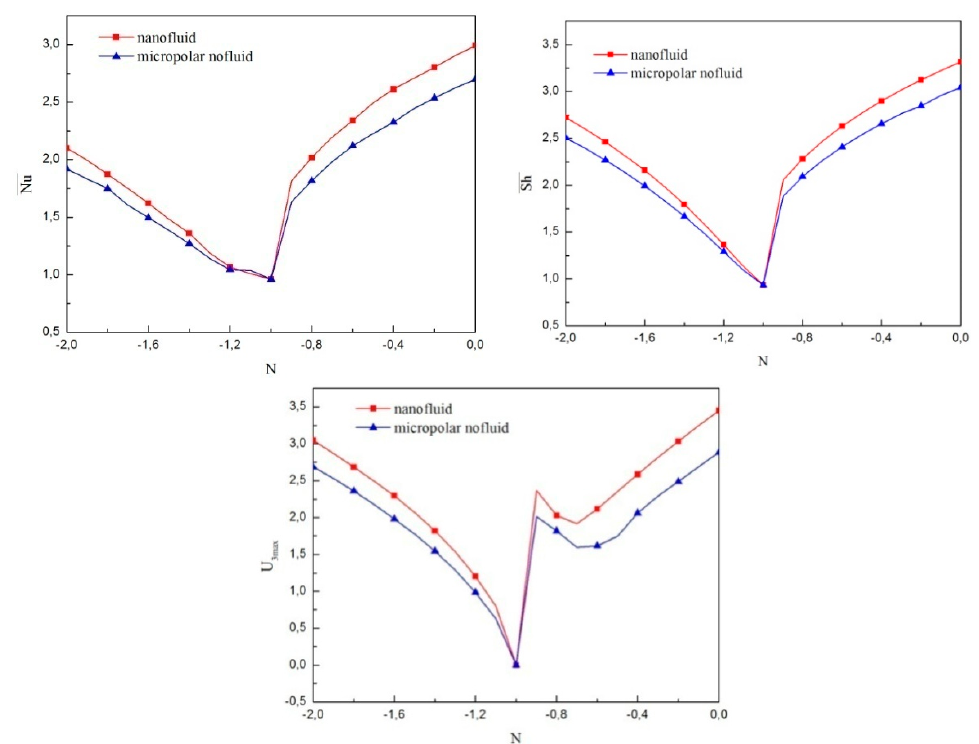
Figure 5. Variation of Nu, Sh and U 3max with buoyancy ratio for both micropolar and non-micropolar nanofluid models for Ra = 10 5 , φ = 0.04, Pr = 6.2 and Le = 1.